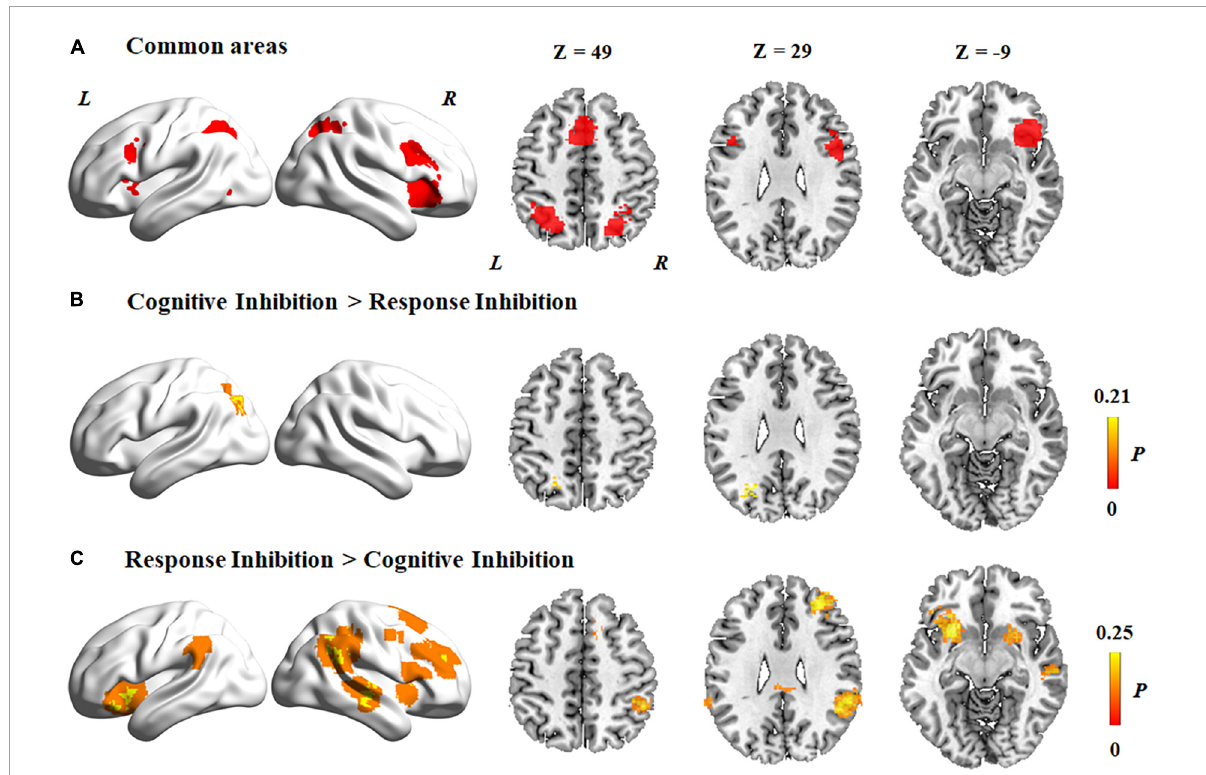
FIGURE3 Common and distinct activation regions between two subcomponents. (A) Common areas between cognitive inhibition and response inhibition. (B) Higher activation in cognitive inhibition than response inhibition. (C) Higher activation in response inhibition than cognitive inhibition. The color bar represents the maximum proportion of studies exhibiting the effect at the peak density weighted by sample size